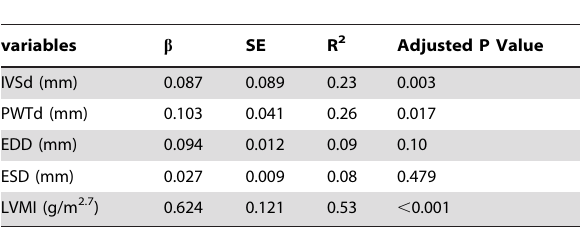
Table 2. Multivariable Analysis Evaluating the Association between GDF-15 and Echocardiographic variables in hypertensive